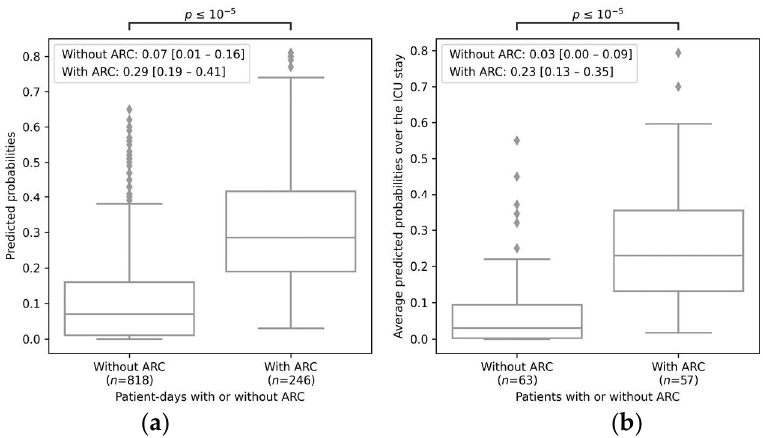
Figure 4. Comparison of predicted probabilities of ARC on the next ICU day between ( a ) patient- days with and without ARC and ( b ) patients with and without ARC during their ICU stay, with predicted probabilities average over their ICU stay, regardless of the presence of ARC on that day.ARC, augmented renal clearance.